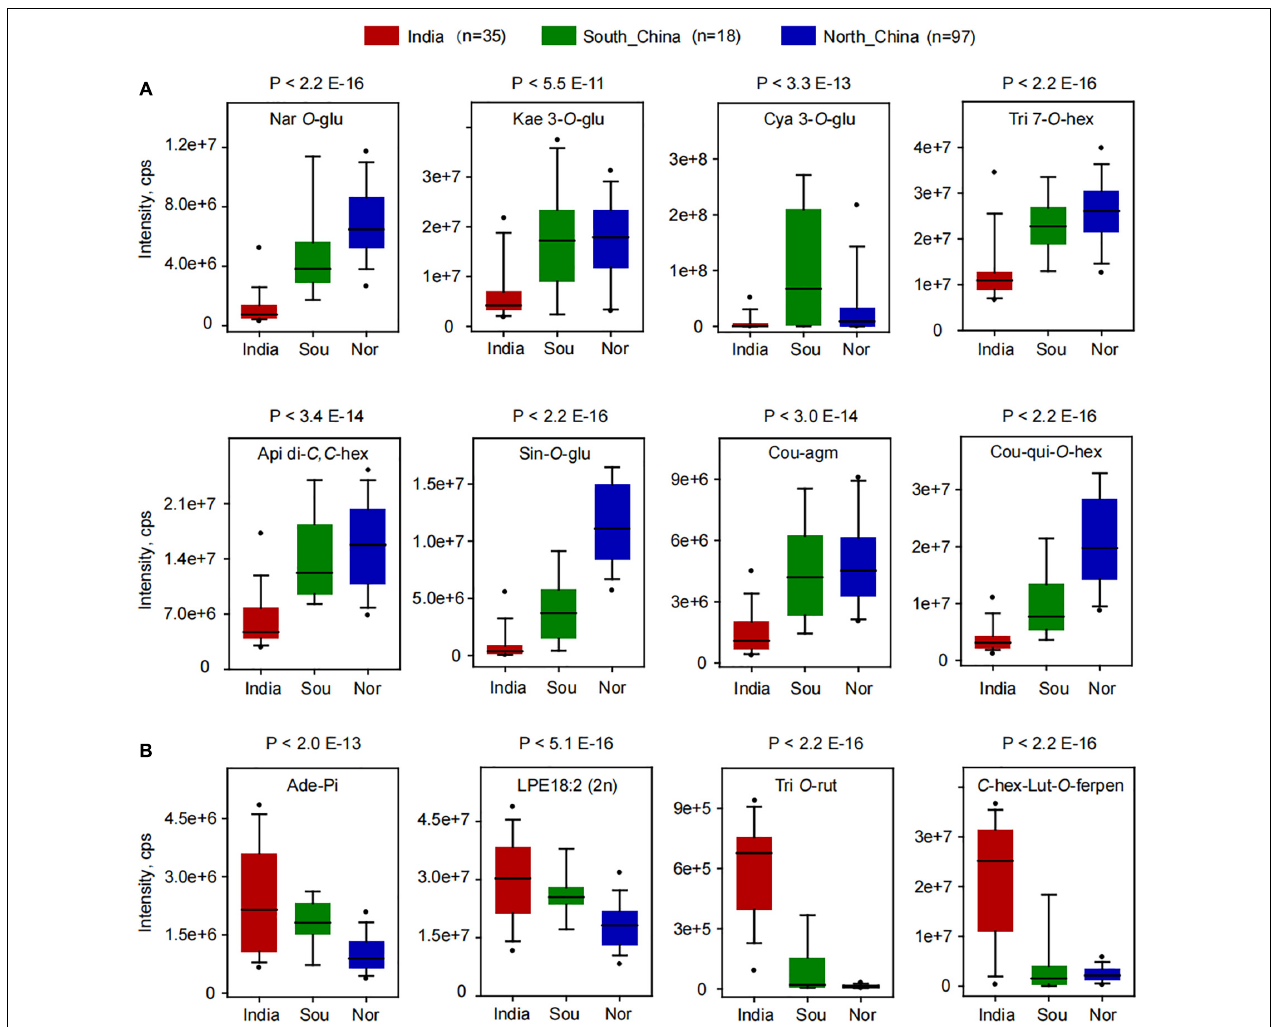
FIGURE 2 | Boxplot for the content of differentially accumulated metabolites among the millets from India, the south of China (Sou), and the north of China (Nor). (A) Significantly higher metabolites were found in millet from northern China. (B) Significantly higher metabolites were found in millet from India. Ade-Pi, adenosine 5 (cid:48) -monophosphate; Api di- C , C -hex, apigenin di- C , C -hexoside; C -hex-Lut- O -ferpen, C -hexosyl-luteolin O -feruloylpentoside; Cou-agm, N (cid:48) - p -coumaroyl agmatine; Cou-qui- O -hex, 3- O - p -coumaroyl quinic acid O -hexoside; Cya 3- O -glu, cyanidin 3- O -glucoside (Kuromanin); Kae 3- O -glu, kaempferol 3- O -glucoside (Astragalin); LPE18:2 (2n), LysoPE 18:2 (2n isomer); Nar O -glu, naringenin O -glucoside; Sin- O -glu, 1- O -beta- D -glucopyranosyl sinapate; Tri 7- O -hex, tricin 7- O -hexoside; Tri O -rut, tricin O